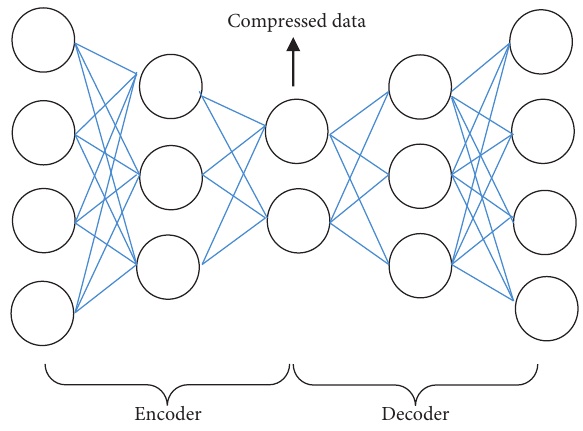
Figure 1: An example of an autoencoder